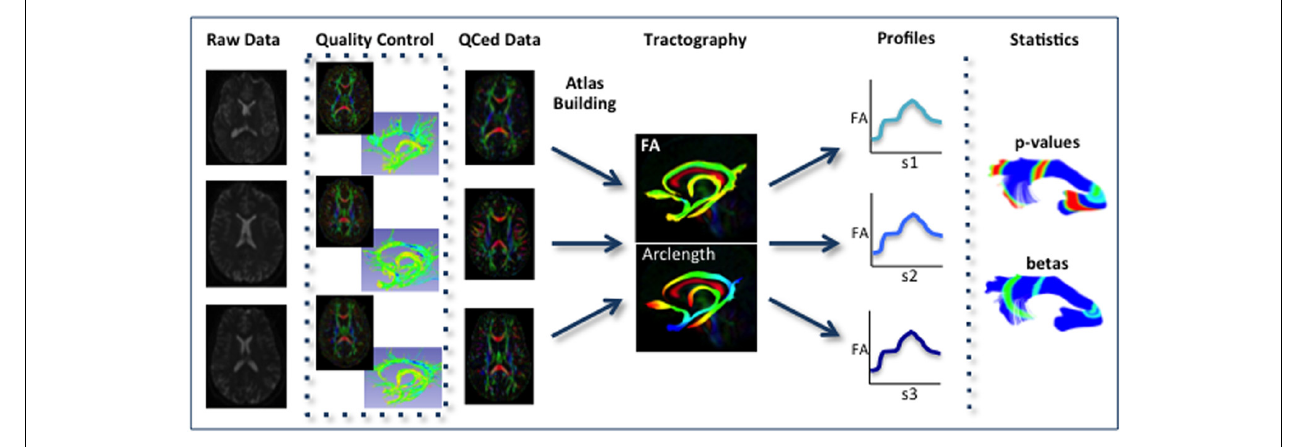
FIGURE 2 | Schematic of DTI processing workflow. The input raw DWI data first undergoes vigorous quality control before the final conversion to DTI for Atlas building. Interactive tractography is performed on the Atlas.